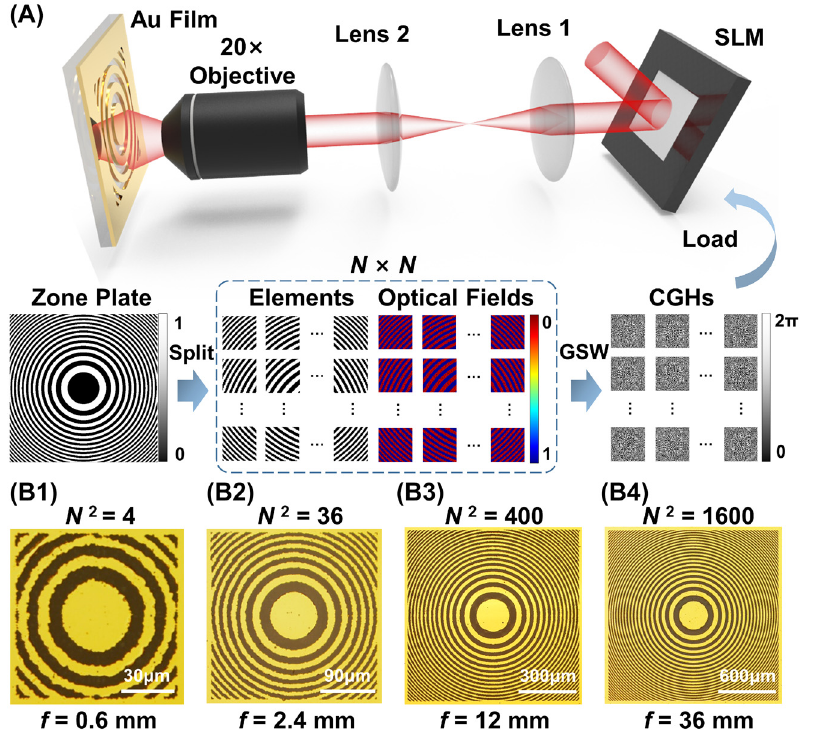
Figure 1: Scheme and experimental